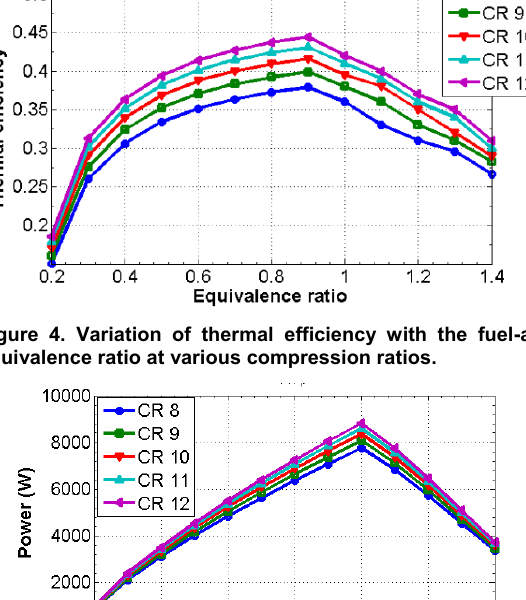
Comparison of the thermal efficiency calculated using the FTT Model with the other models.